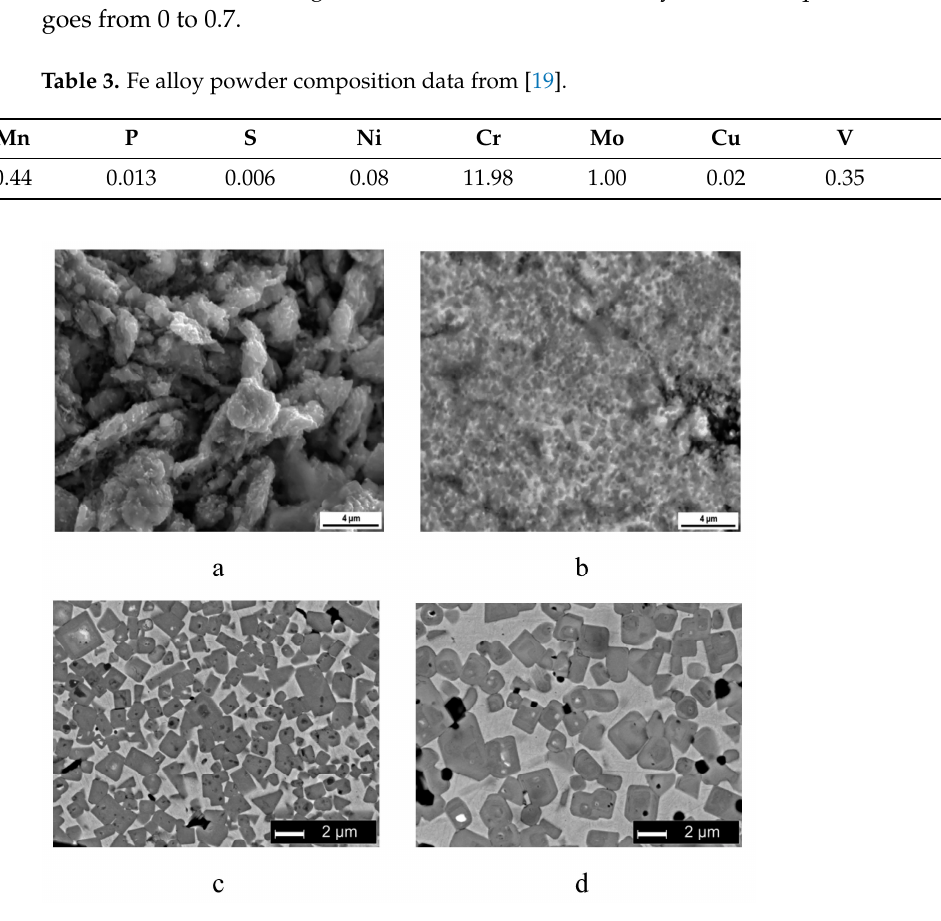
Figure 12. Volume fraction of stable phases for matrix alloy composition of Table 3 as a function of Figure 12. Micrographs showing reinforcement growth according to sintering temperature. Sinter- temperature. M represents the metallic atoms, with Ti being the major ing at ( a ) 1273 K for 30 min, ( b ) 1573 K for 30 min, ( c ) 1673 K for 30 min, and ( d ) 1673 K for 300 min (reproduced with permission [86]).